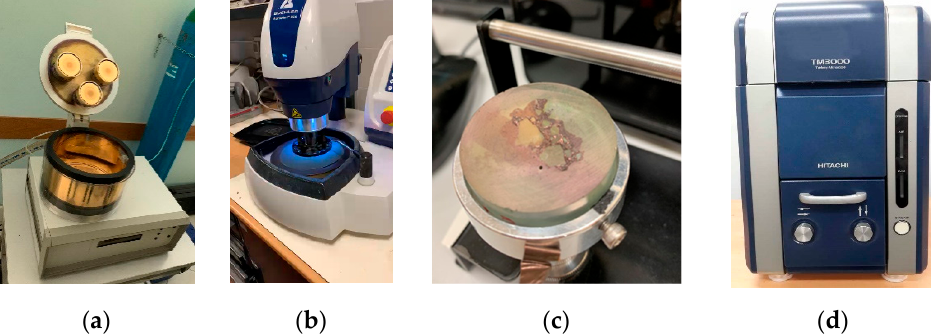
Figure 10. SEM specimen preparation: ( a ) smoothening of the specimen; ( b ) coating with the metal; ( c ) specimen type; and ( d ) Hitachi TM3000 device.